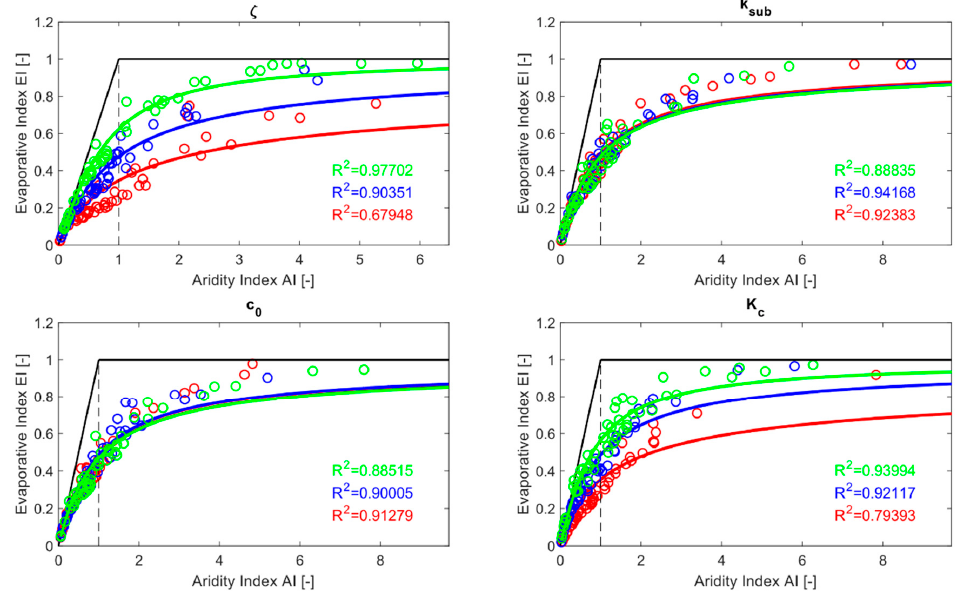
Figure 4. Fu’s curves obtained considering the test-watershed parameters (blue line, Table 2, last column) and perturbating one parameter at time (one for each panel), testing their minimum (red line, Table 2 second column) and maximum values (green line, Table 2 third column). R 2 has been reported for the associated curves.